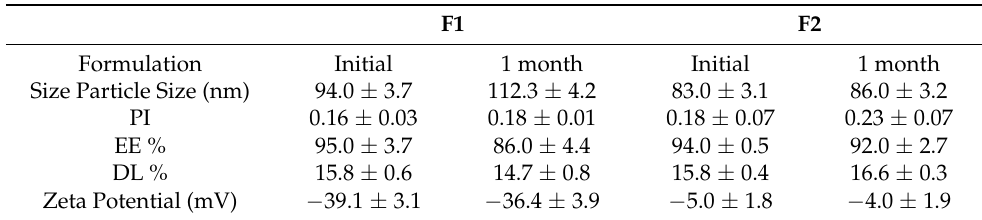
Table 3. Stability of formulations stored at 4 ◦ C under N 2 and protected from light for 1 month. Values represented as mean ± SD, n = 3. F1 F2 Formulation Initial 1 month Initial 1 month Size Particle Size (nm) 94.0 ± 3.7 112.3 ± 4.2 83.0 ± 3.1 0.16 ± 0.03 EE % 95.0 ±